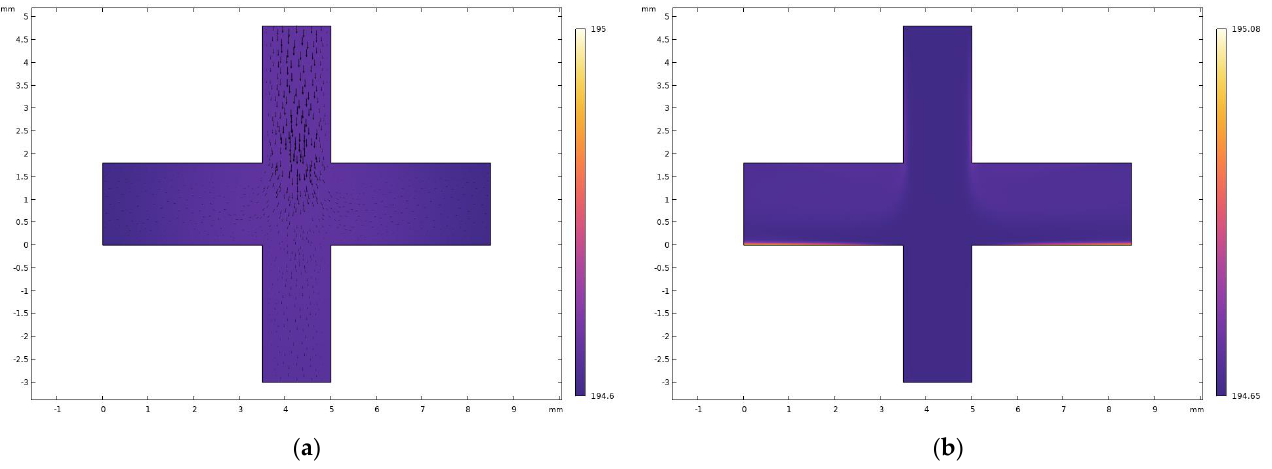
Figure 14. ( a ) Temperature distribution of VI at 1 s for the transient solver; ( b ) temperature distribution after stabilization of VI obtained by the steady-state solver.